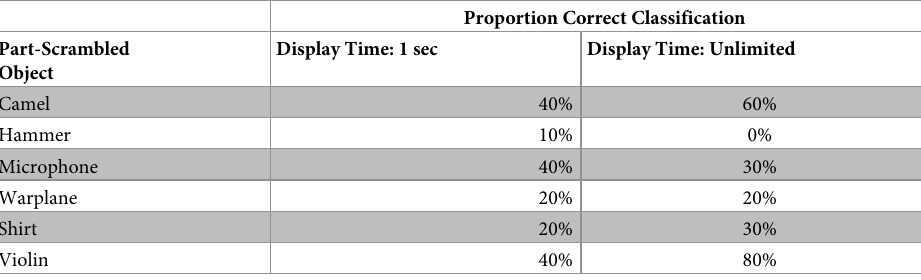
Table 1. Human observers’ performance on individual items for part-scrambled